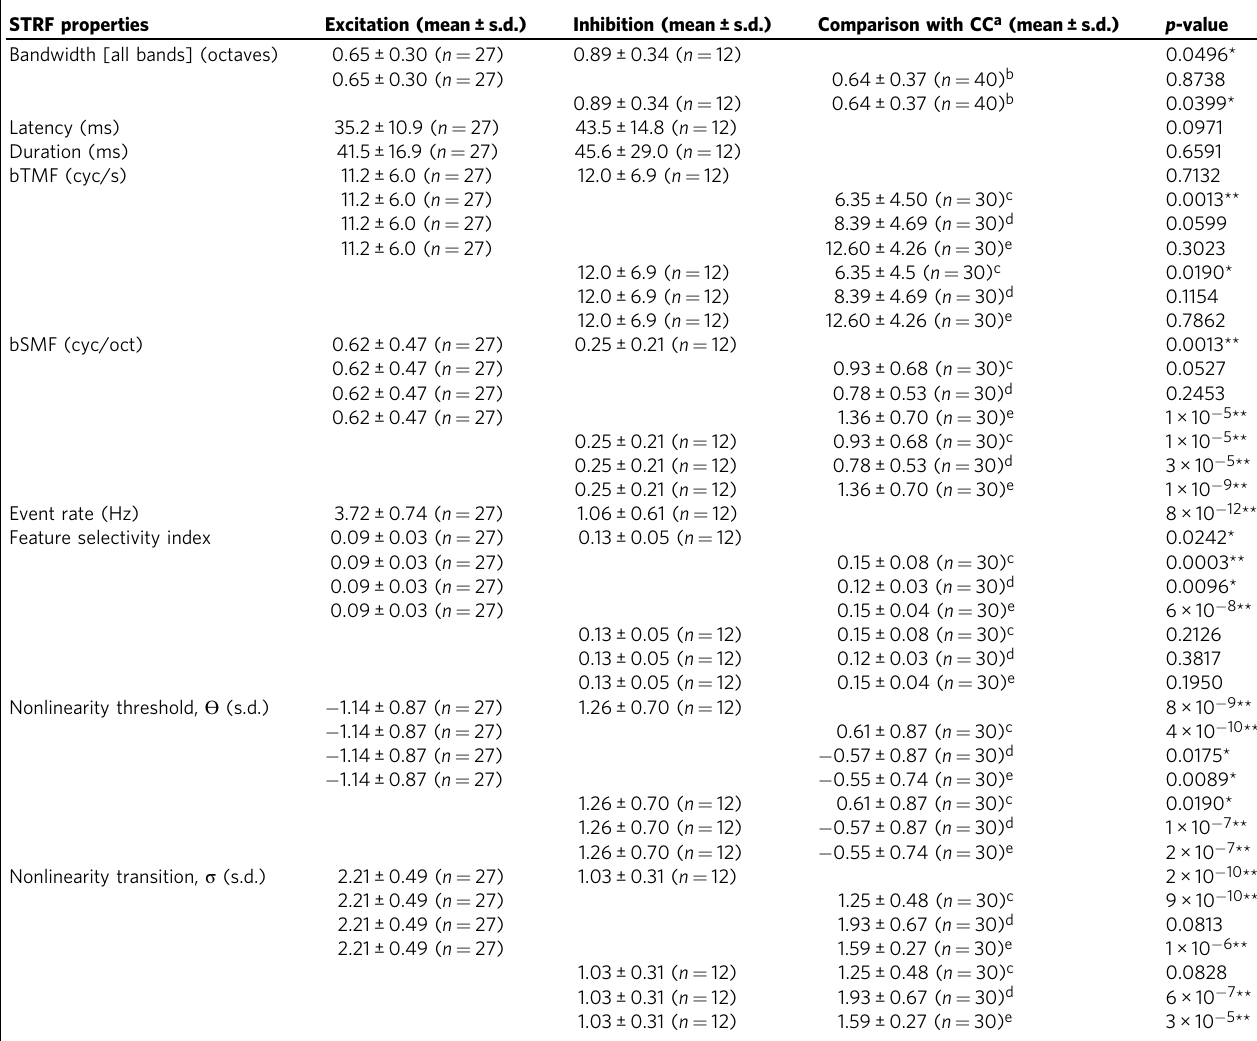
Table 2 Functional properties of excitatory and inhibitory synaptic STRFs. STRF properties Excitation (mean ± s.d.) Inhibition (mean ± s.d.) Comparison with CC a (mean ± s.d.) p -value